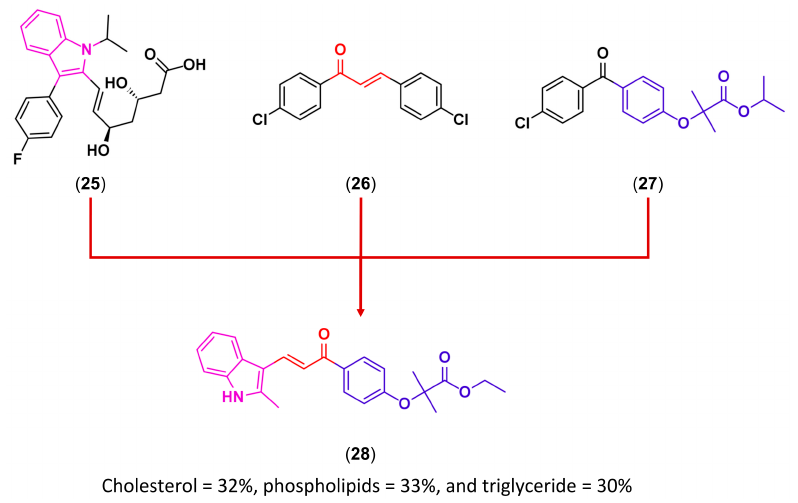
Figure 9. Molecular hybrids obtained from a combination of Fluvastatin (purple), fenofibrate (blue), and chalcones (red) [67].